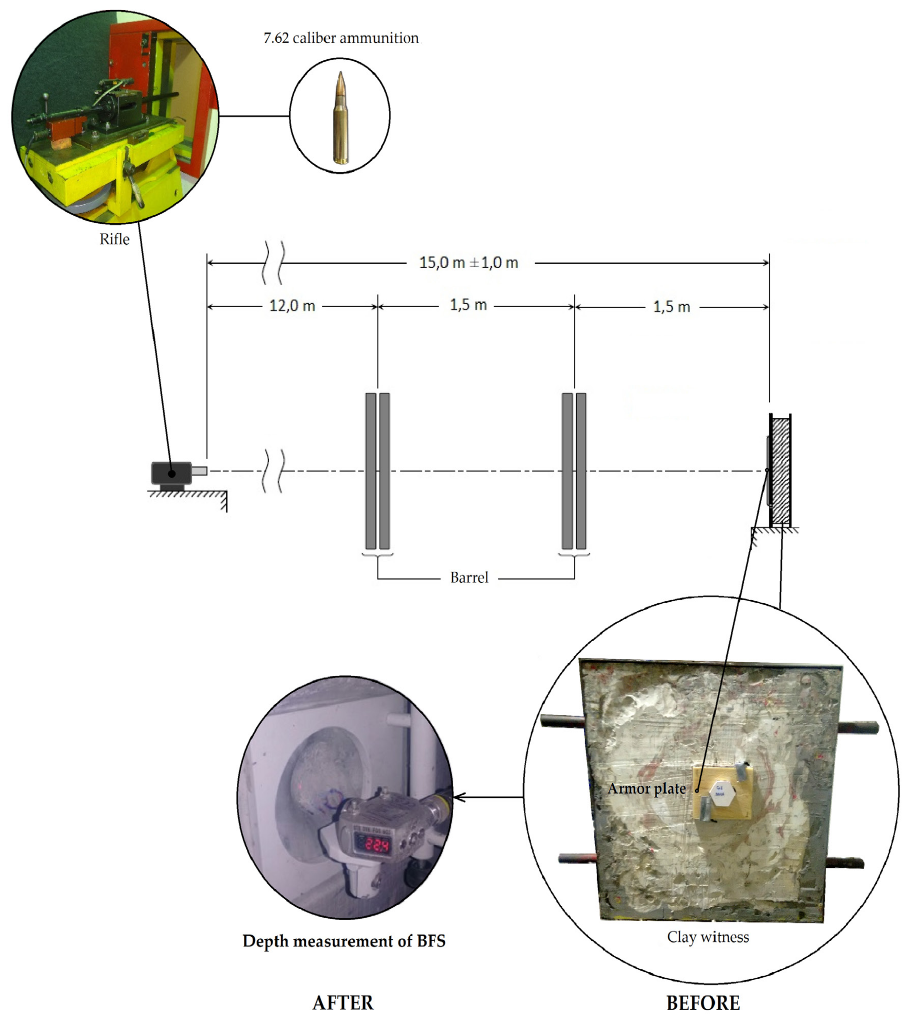
Figure 3. Schematic diagram showing the experimental arrangement (adapted from NIJ standard [11]).